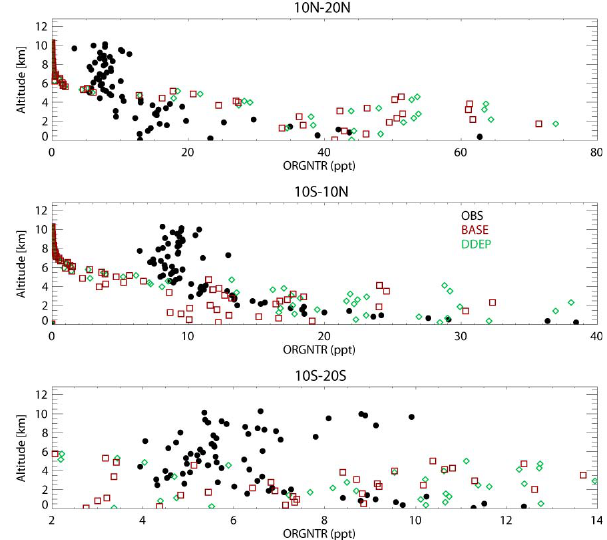
Fig. 7. A comparison of the distribution of CH 3 ONO 2 around the tropical Pacific Ocean as measured during March 1999 in the PEM- Tropics B measurement campaign and simulated in TM5. Com- parisons are shown for EMISS (orange), FLIGHT (light blue), LOWBR (dark blue), FULL (red) and DDEP (green). The reader should note the different scales on the x axis between latitudinal regions.